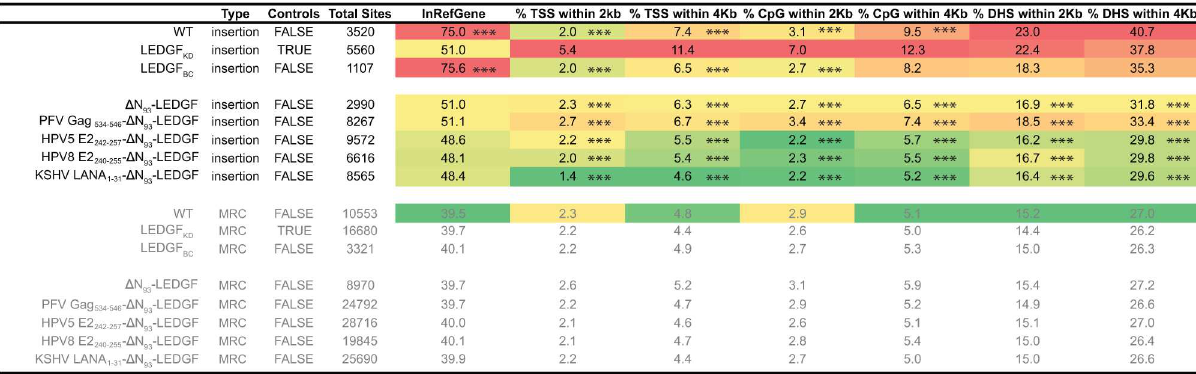
Fig 4. Rescue of lentiviral vector transduction by artificial LEDGF-hybrids. LEDGF-fusions were evaluated for their ability to support lentiviral vector transduction. LEDGF-depleted HelaP4-based cell lines stably complemented with LEDGF-hybrids were challengedwith a VSV-G pseudo-typed lentiviral reporter vector encodingenhancedGreen Fluorescent Protein (eGFP). Fluorescence was measured by fluorescence activated cell sorting and the different variablesplotted:. (a) PercentageeGFP positive cells (transduction efficiency) and (b) Mean Fluorescence Intensity (MFI). Data are compiledfor a representative experimentand depict averages of 3 replicatesfor 3 different vector dilutions (mean ± SD). (c) Lentiviralintegrated proviral copies were determinedby Q-PCR analysison genomic DNA extracts of cells transduced with an MOI = 1. Data are represent the mean of 3 replicates ± SD. Statistical significanceis calculated using a two-tailedt-test relative to LEDGF KD or Δ N 93 -LEDGF. PFV, Prototype foamy virus; LANA, Latency associated nuclear antigen; HPV, Human papillomavirus; LEDGF, Lens epithelium-derived growth factor.